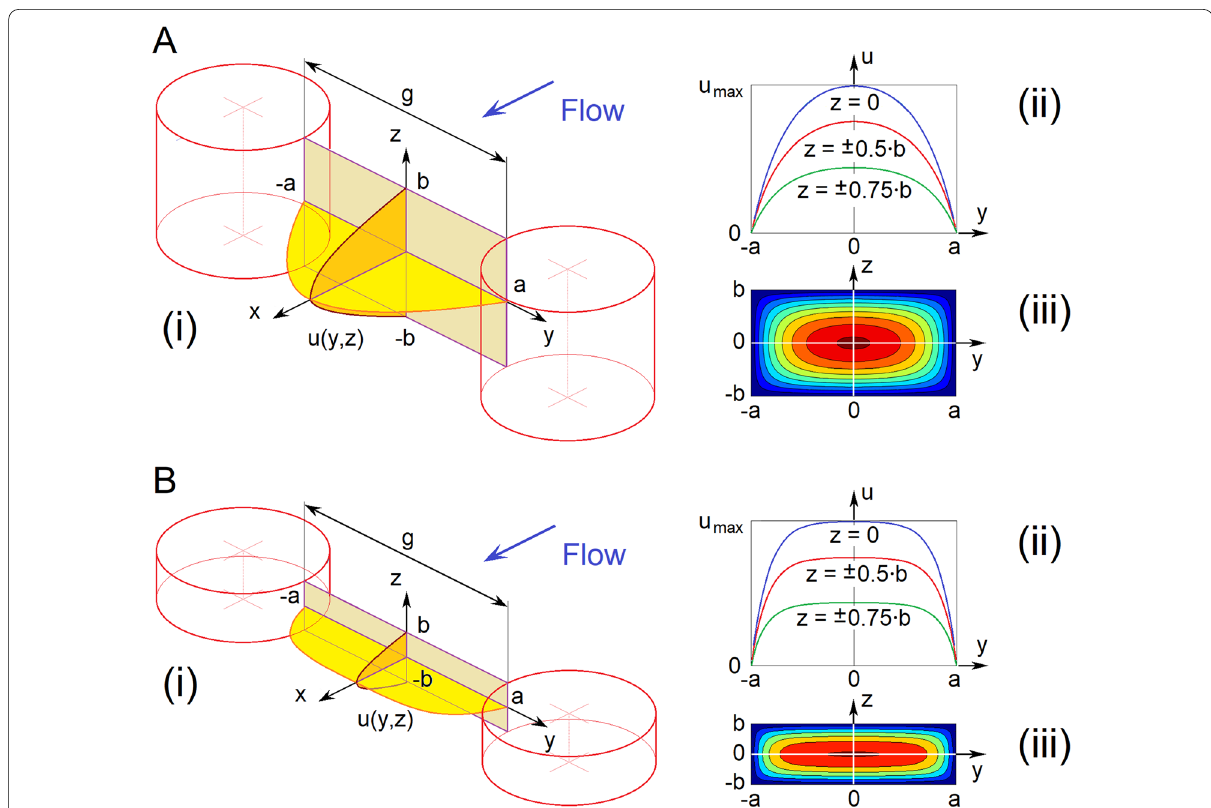
Fig. 3 Microfluidic channel height effect on the velocity profile. Height-to-width aspect ratio a / b is 1/2 ( A ) and 1/4 ( B ). (i) Flow between two posts is modeled as laminar flow in a rectangular channel. (ii) Velocity profile in different planes z flow through the rectangular